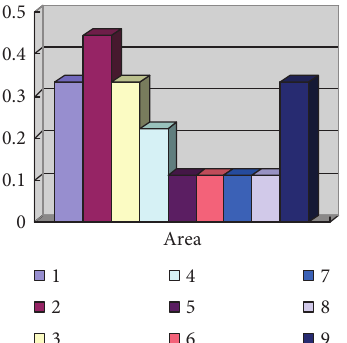
Figure 1: Proportion of the number of adjacent areas in each area of the target image.